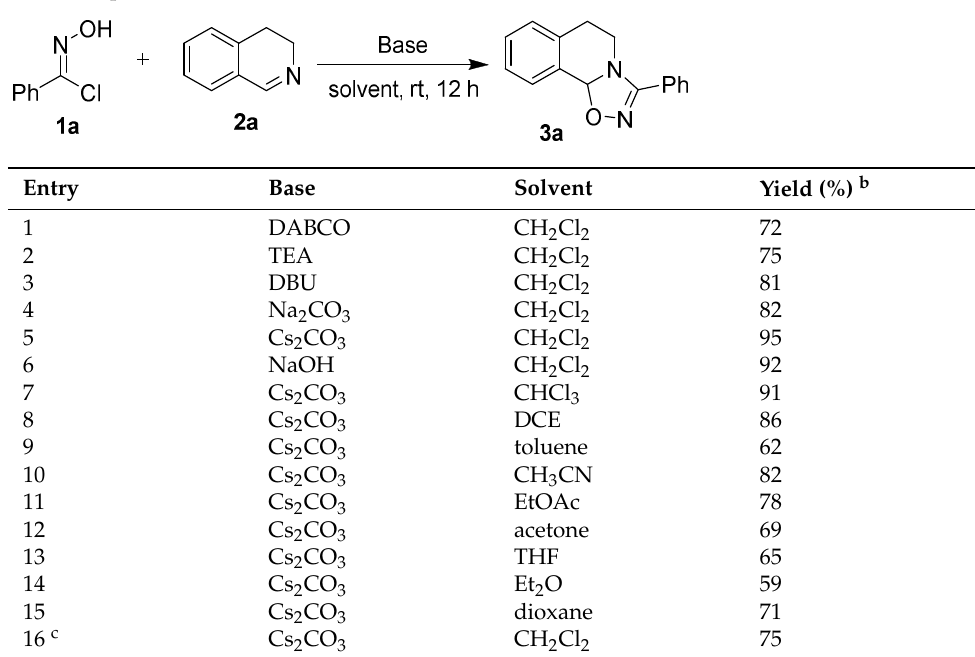
Table 1. Optimization of reaction conditions a .